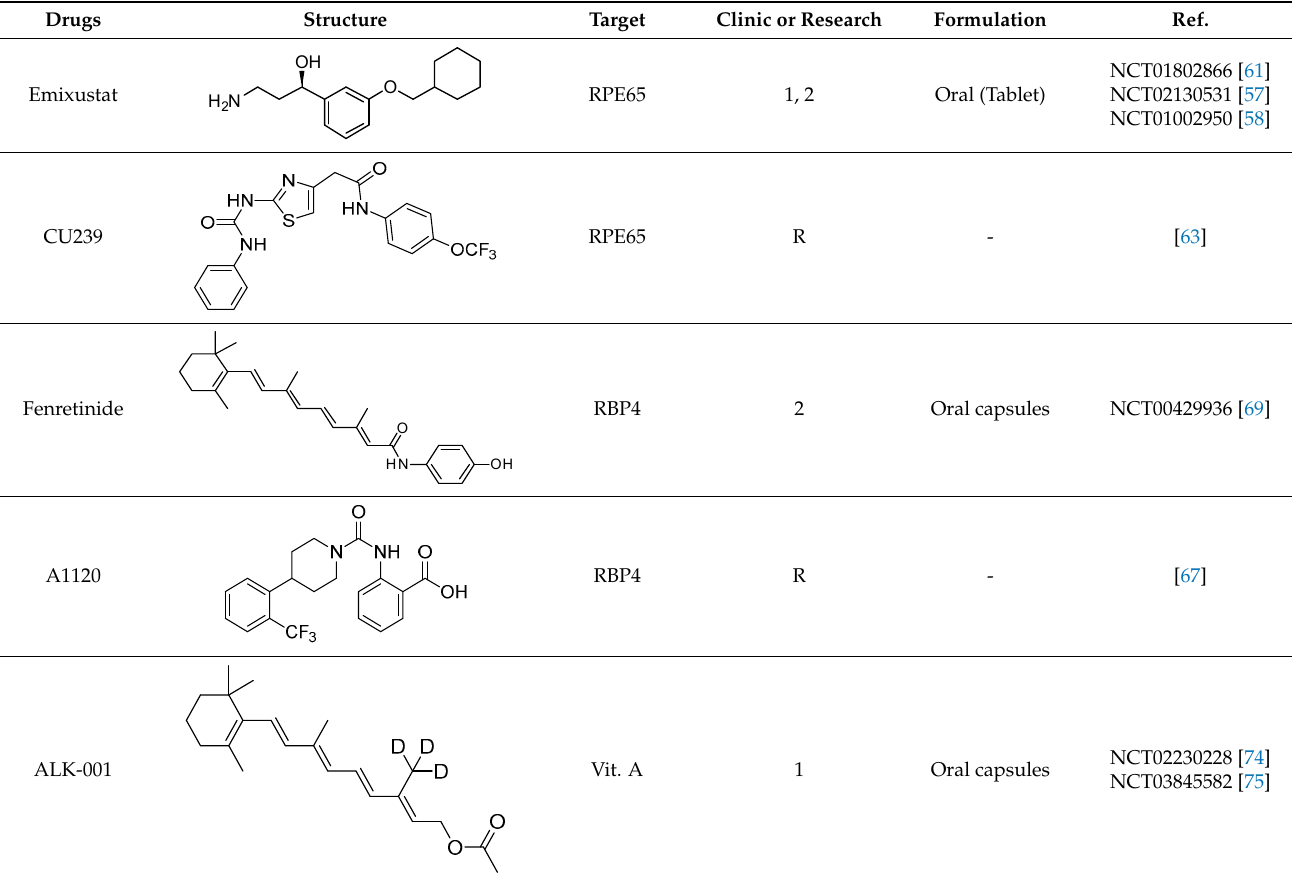
Table 1. Drugs targeting the visual cycle.